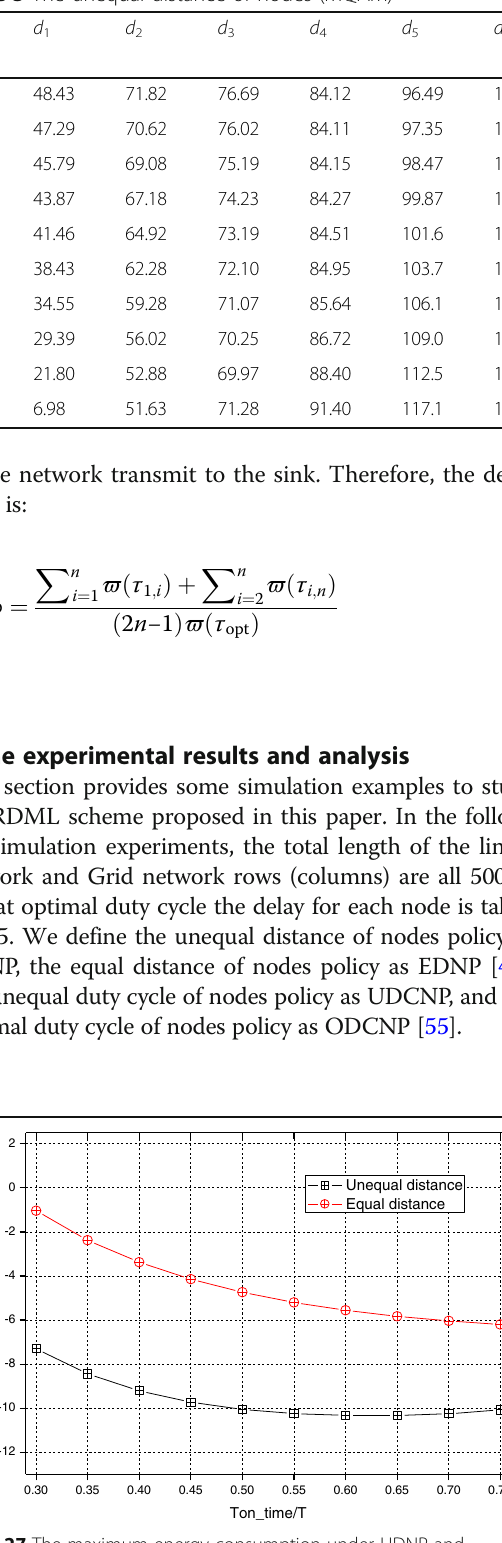
Fig. 27 The maximum energy consumption under UDNP and EDNP (MQAM)